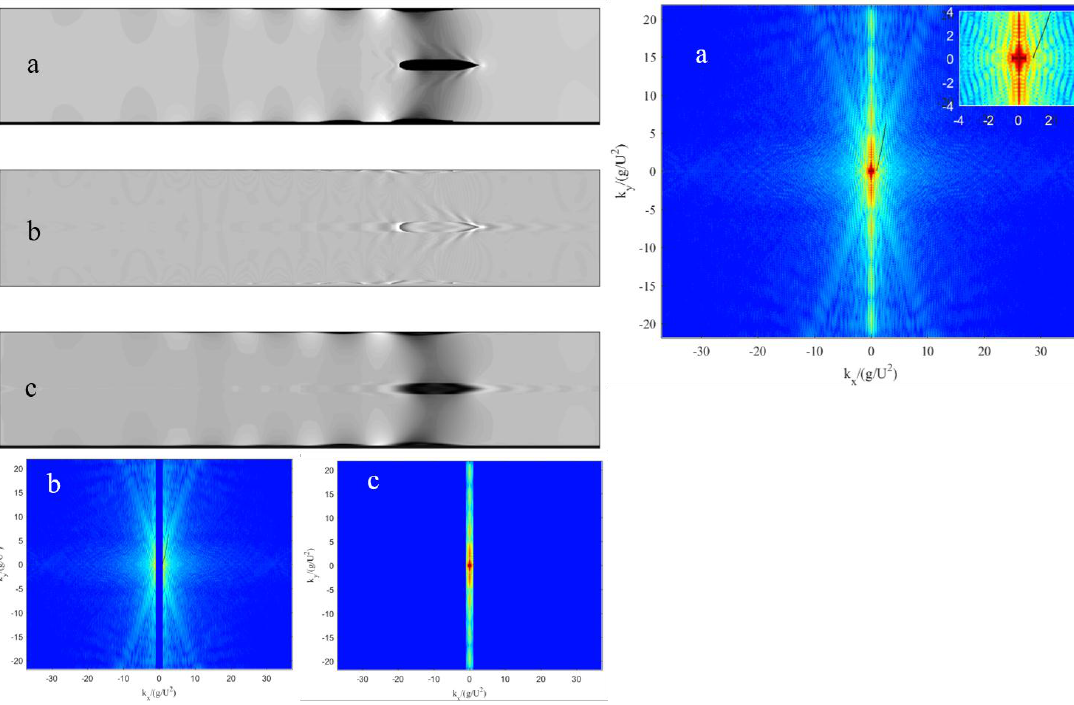
Figure 16. Free surface disturbance in the Suez Canal, F h = 0.57; ( a ) Computed free surface. ( b ) Far-field and ( c ) near-field representations in the real and spectral space ( k c x = 9.5796). Longitudinal extent: 13 m.